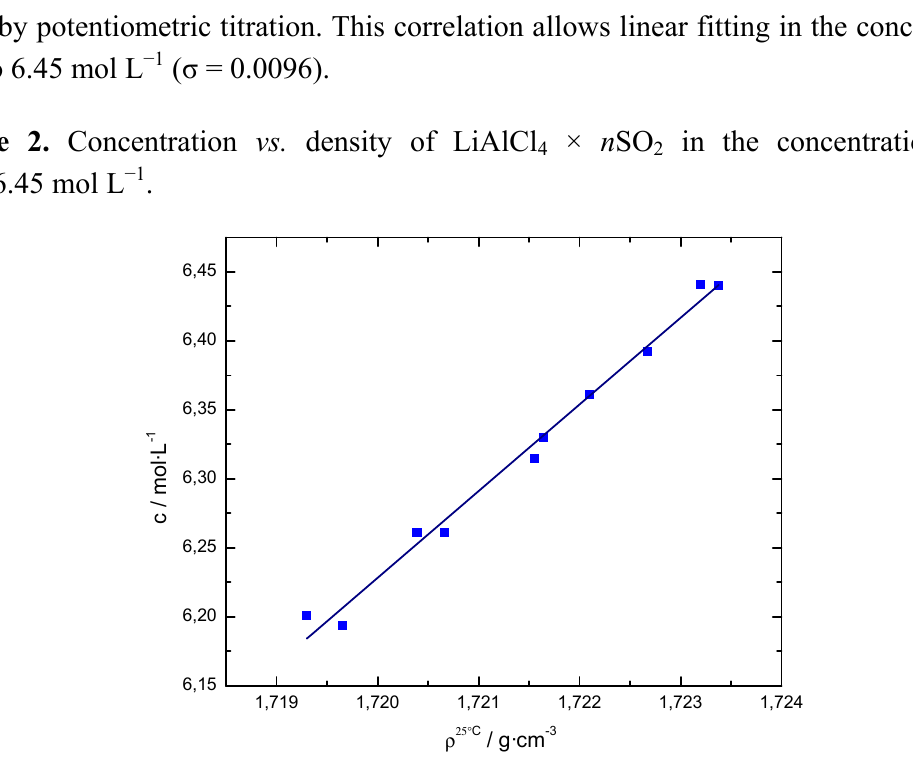
× n SO in the concentration range 4 2